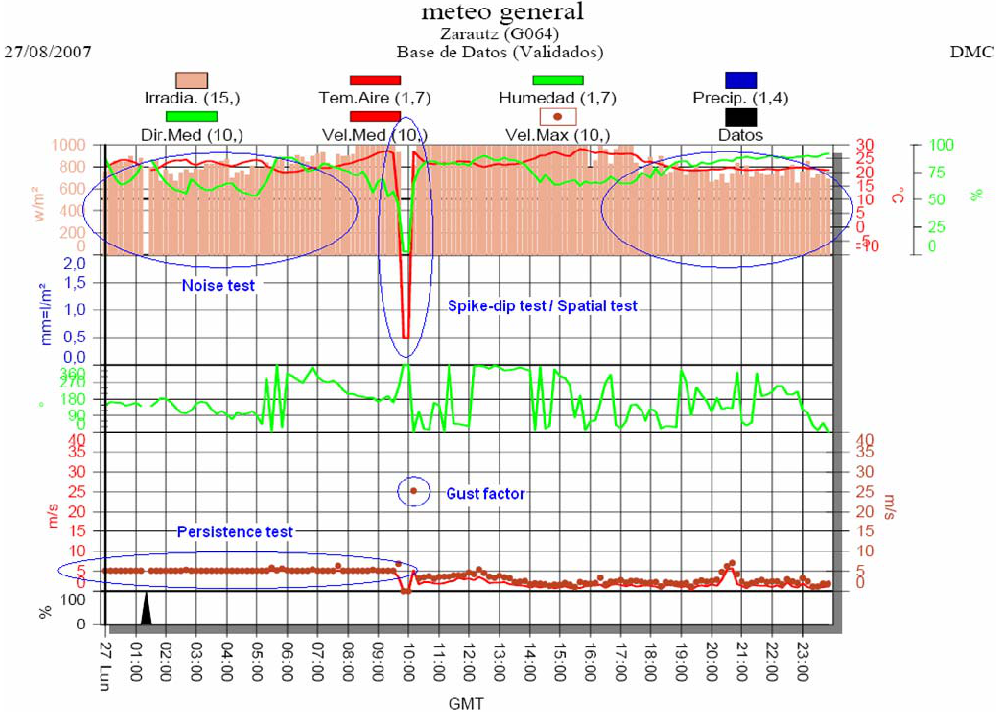
Figure 3. This chart shows data from an AWS on a given day with di ff erent types of errors in measurement sensors and what kind of test would be capable of detecting them. Figure 3: This chart shows data from an AWS on a given day with different types of errors in 3 measurement sensors and what kind of test would be capable of detecting them. 4